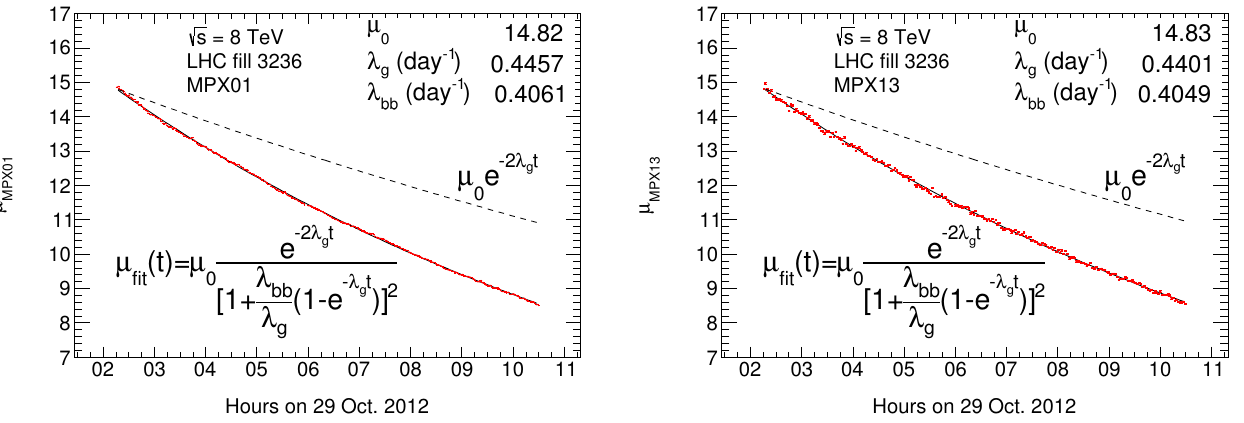
Figure 11. Average number of interactions per bunch crossing, µ , as a function of time seen by MPX devices with highest particle flux (MPX01 and MPX13). The distribution is approximately described by a function as given in the figure. The parameters are defined in the text. The statistical uncertainties per data point are indicated. They depend on the hit statistics scaled by a factor N hit / N cl given in Table 5. In addition to the fit result described by the solid line, the dashed line shows the result of beam–gas interactions alone µ 0 exp ( − 2 λ g t ) , with µ 0 and λ g obtained from the three-parameter fit. LHC fill 3236. See Section 2.5 for the details. Taken from Ref.